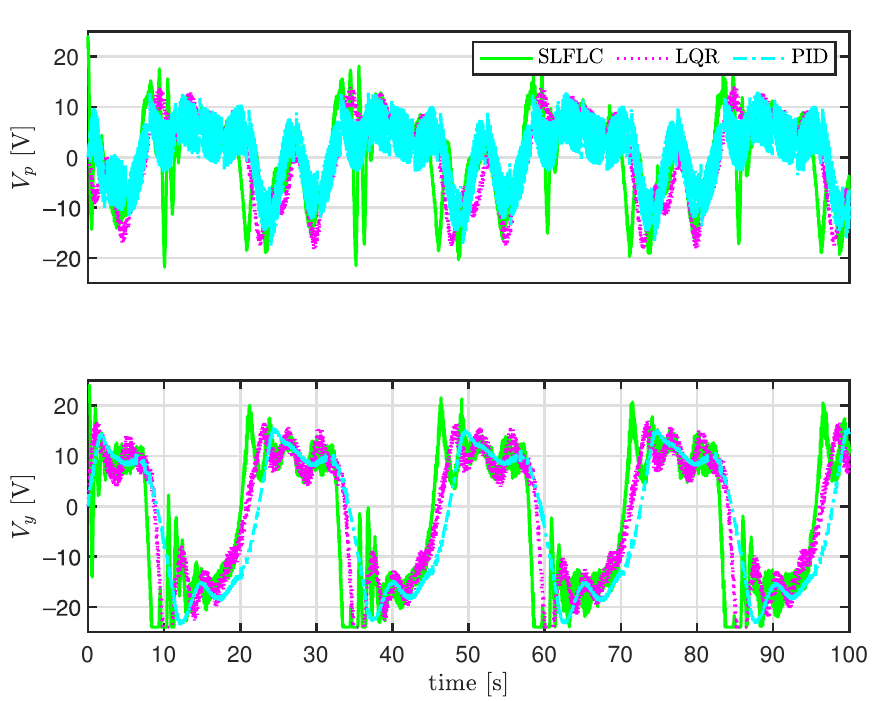
Figure 17. Input voltages (Case